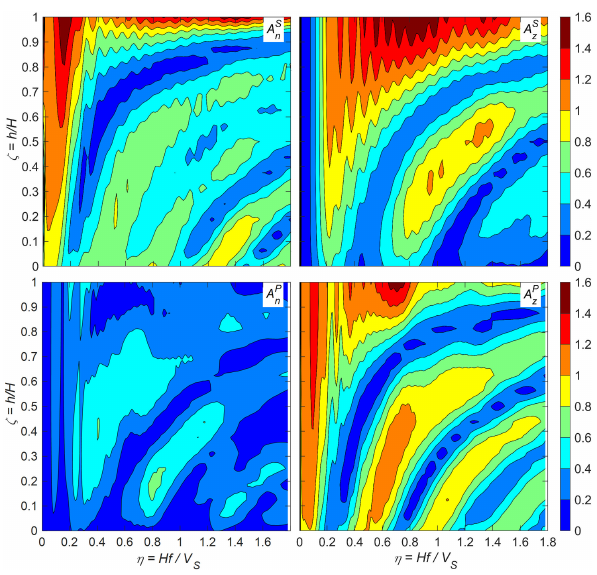
Figure 5. Amplification ratios with respect to the outcrop motion along the vertical wall of a step-like slope. Incident S-wave ( A S n , A S z ) and incident P-wave ( A P n , A P z ) . equivalent, respectively, to an S- and a P-wave in a vertical plane normal to the slope face, their Fourier transform a n (η) and a z (η) are multiplied to the transfer (amplification)